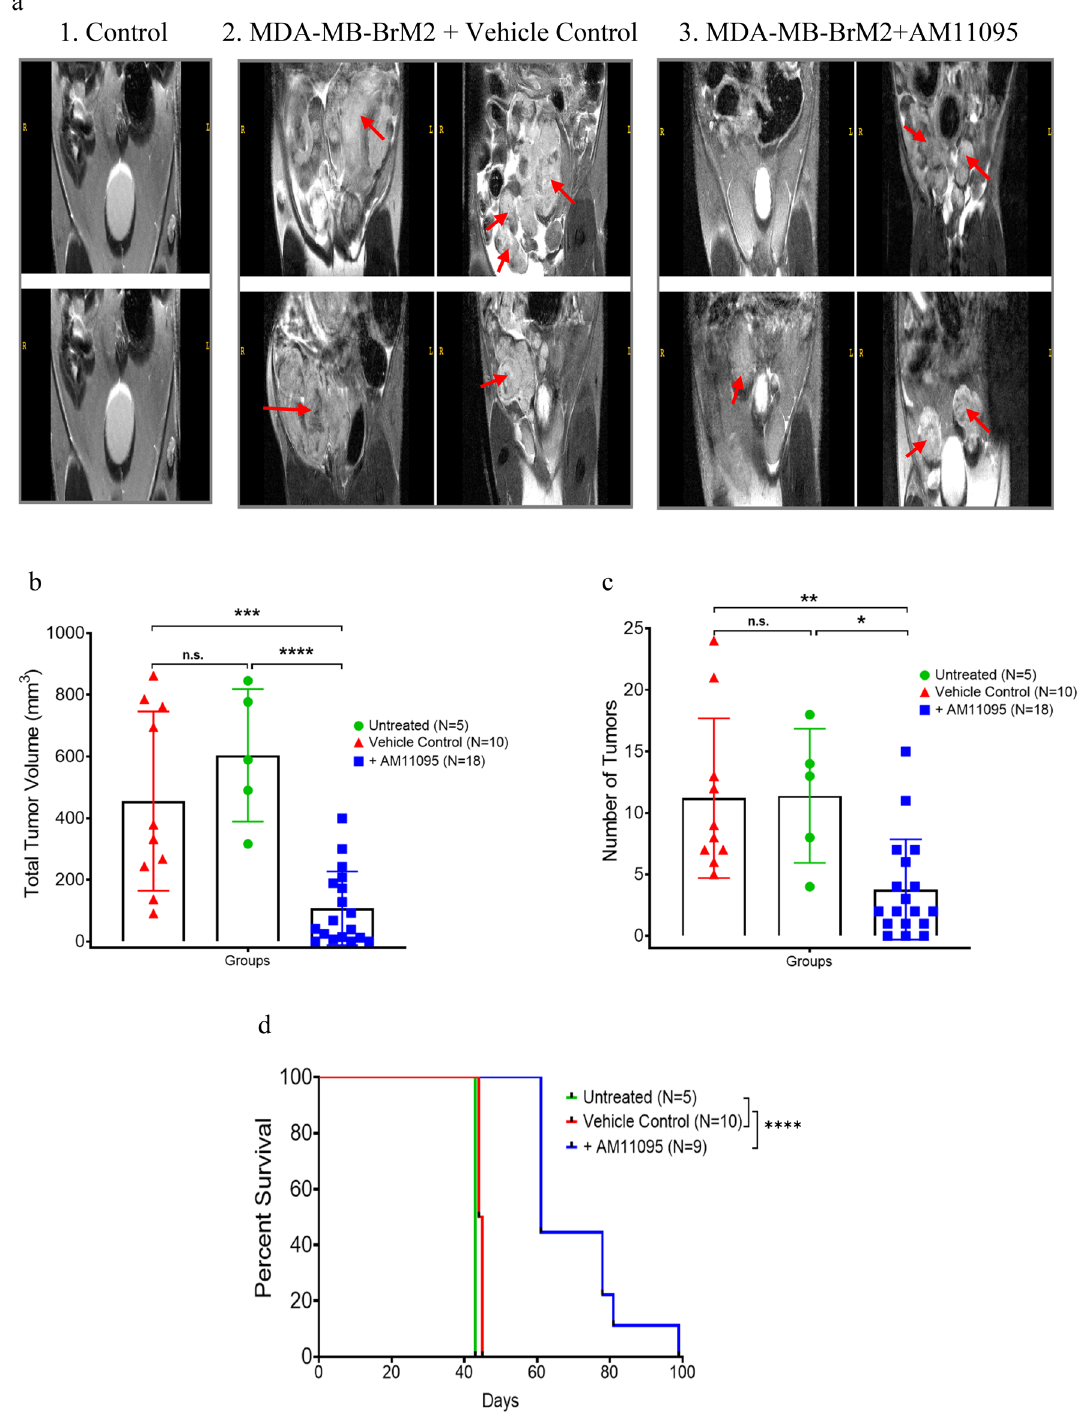
Figure 6. MRI analysis and Endpoint visualization of control nude mice and nude mice administered with tumor cells and either untreated, or vehicle control treated or AM11095 treated at day 28 endpoint. ( a ) (1) Representative images at day 28 showing visualization of control nude nice. (2) Representative images at day 28 showing regions of signal hypersensitivity where tumors developed in nude mice administered with tumor cells and treated with vehicle control. (3) Representative images at day 28 showing regions of signal hypersensitivity where tumors developed in nude mice administered with tumor cells and treated with AM11095. Arrows show the tumor areas. ( b ) The volume size of tumors in the nude mice were analyzed at endpoint in mice administered with tumor cells and either untreated or treated with vehicle control or with AM11095. Each symbol represents the value of an individual mouse. The p-values were calculated by Unpaired Student’s t-Test. ( c ) Number of tumors detected with MRI (n = 20) at endpoint in mice administered with tumor cells and either untreated or treated with vehicle control or with AM11095. Each symbol represents the value of an individual mouse. The p values were calculated by Unpaired Student’s t-Test. ( d ) Survival analysis of AM11095 treated mice. Mice were divided into three groups based on the treatment. The p-values were calculated by Unpaired Student’s